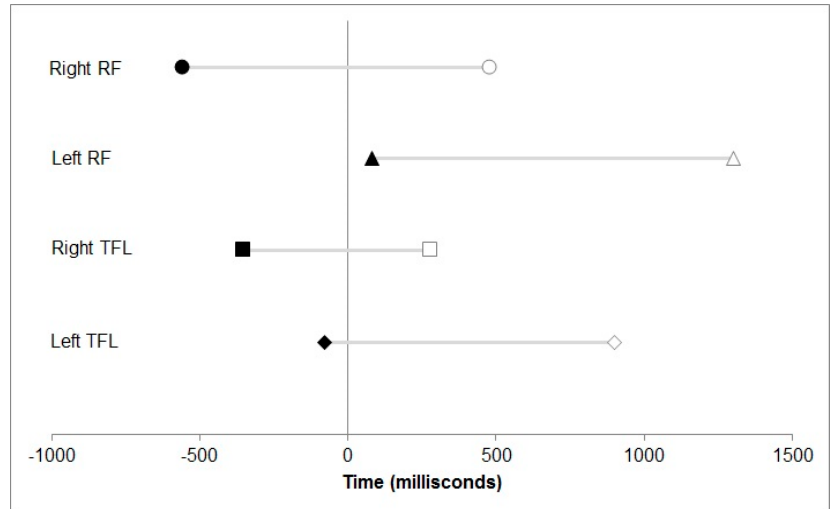
Figure 6. Onset timing of electromyographic (EMG) activity for the tensor fascia latae (TFL) and rectus femoris (RF) muscles pre-intervention (white symbols) and post-intervention (black symbols). Timing (milliseconds) is expressed relative to the initiation of hip flexion (time zero).